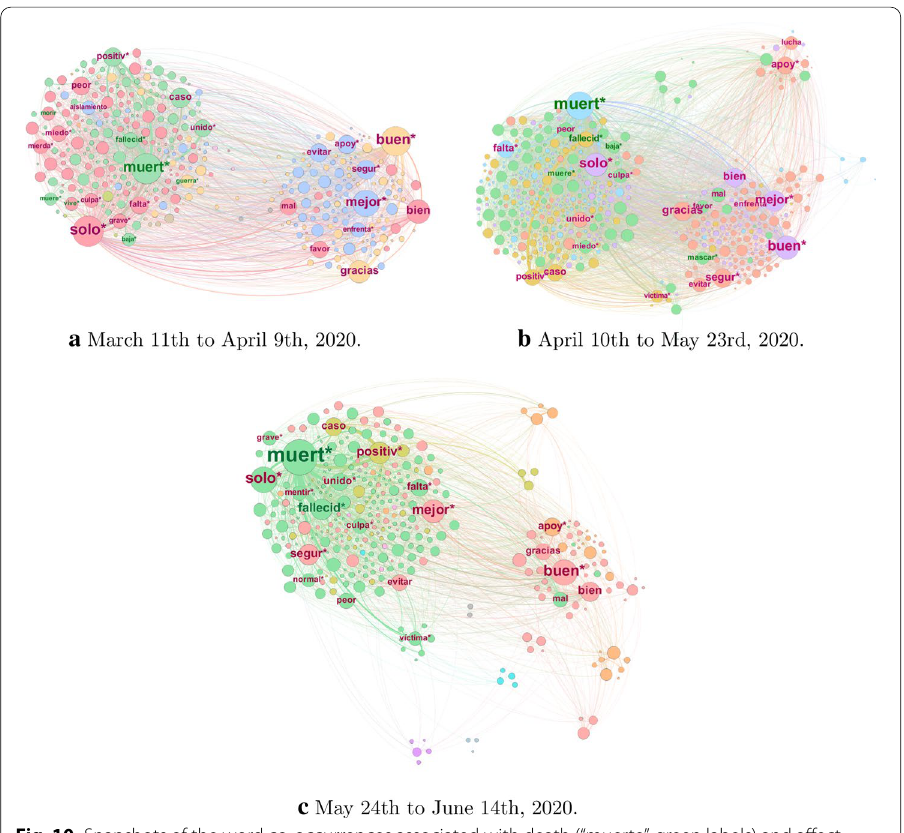
Fig. 10 Snapshots of the word co-occurrences associated with death (“muerte”, green labels) and affect (“afecto”, red labels) for Spanish-language tweets aggregated across all analyzed countries in three different time windows (see sub-captions). The nodes are coloured based on the community labels obtained by maximising modularity using the Louvain algorithm (Blondel et al. 2008). We filtered edges with weight below 20 co-occurrences for visualisation